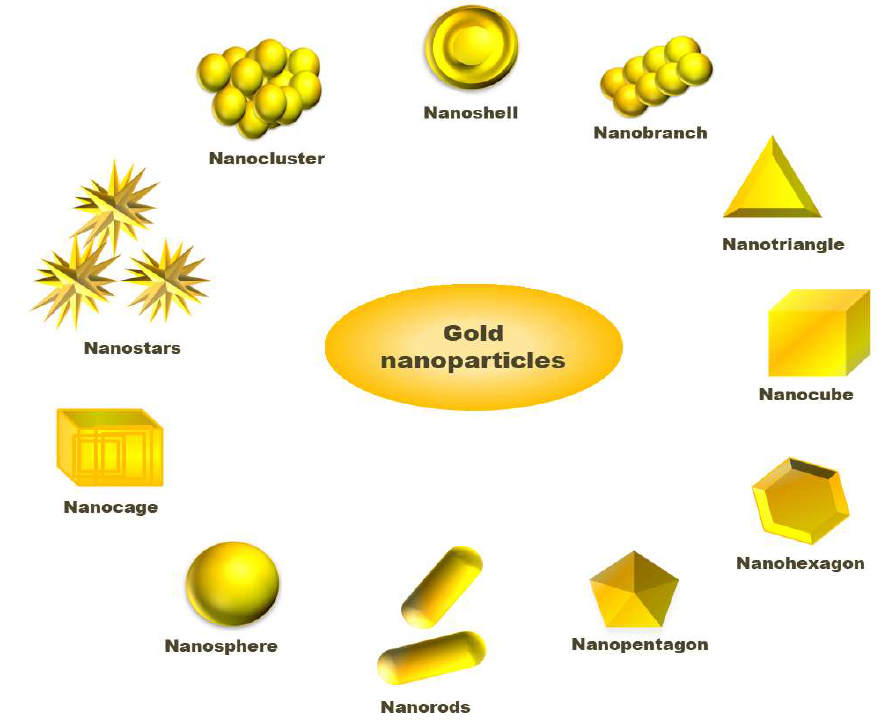
Figure 2. Different shapes available for gold nanoparticles.